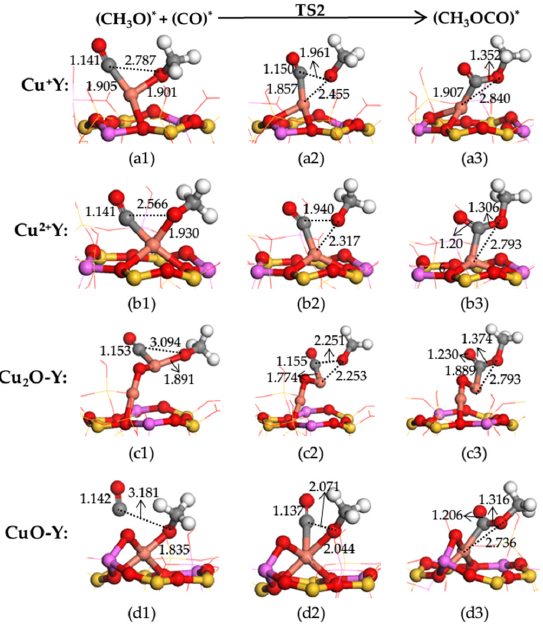
Figure 6. The structures of reactants, products and transition states on Cu + Y, Cu 2+ Y, Cu 2 O-Y and CuO-Y zeolite for the formation of CH 3 OCO (unit: Å). ( a1 ) (CH 3 O) * /(CO) * on Cu + Y, ( a2 ) TS2 on Cu + Y, ( a3 ) (CH 3 OCO) * on Cu + Y, ( b1 ) (CH 3 O) * /(CO) * on Cu 2+ Y, ( b2 ) TS2 on Cu 2+ Y, ( b3 ) (CH 3 OCO) * on Cu 2+ Y, ( c1 ) (CH 3 O) * /(CO) * on Cu 2 O-Y, ( c2 ) TS2 on Cu 2 O-Y, ( c3 ) (CH 3 OCO) * on Cu 2 O-Y, ( d1 ) (CH 3 O) * /(CO) * on CuO-Y, (d2) TS2 on CuO-Y and ( d3 ) (CH 3 OCO) * on CuO-Y. See Figure 4 for the color coding. 3.3. CH 3 O Reacts with CH 3 OCO to Form DMC (Path I) (CH 3 OCO) * adsorbed on these four types of zeolites can react with another (CH 3 O) * to form DMC, via a transition state TS3 (see Figure 7).